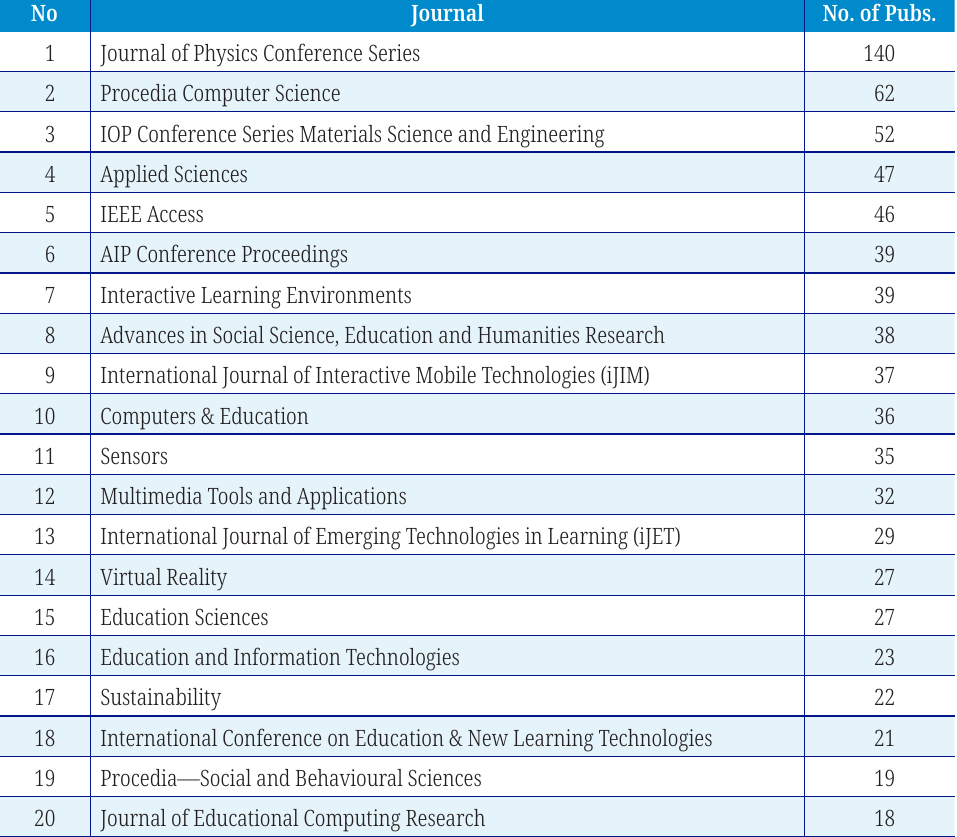
Table 6. Top 20 journals and proceedings with most publications on AR/VR for